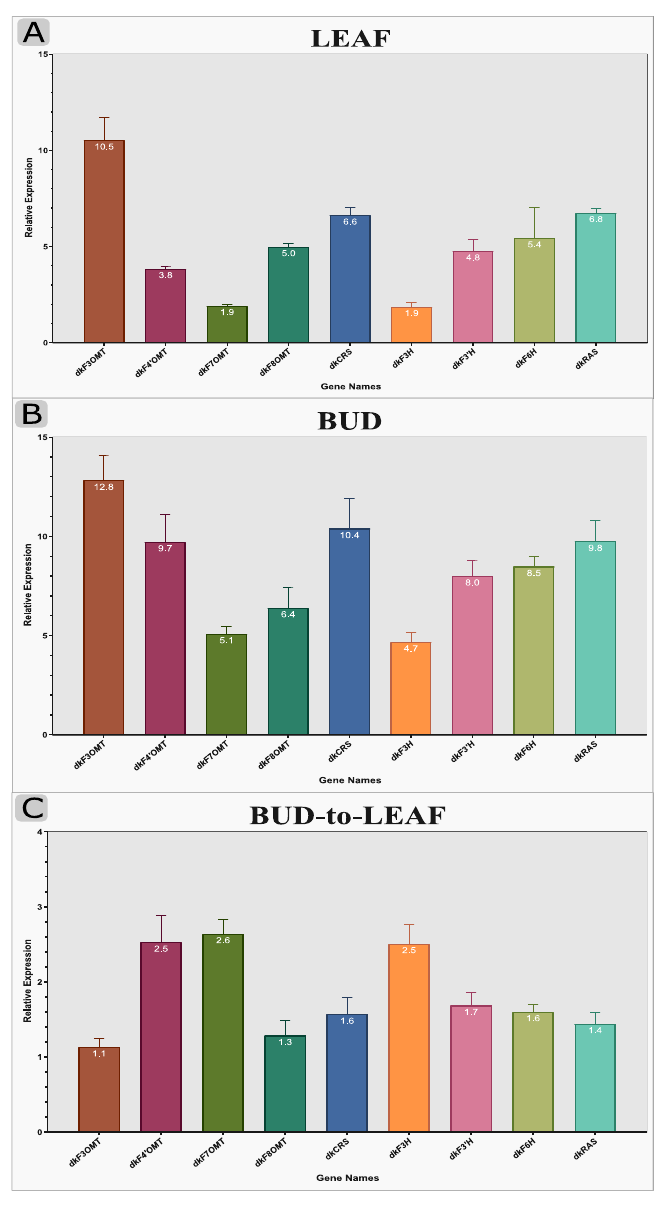
Figure 3. Expression pattern of selected genes from methoxylated flavones and rosmarinic acid biosynthetic pathway using qRT-PCR in D. kotschyi . Nine genes involved in methoxylated flavones and rosmarinic acid biosynthesis, namely; F3OMT, flavonoid 3-O-methyltransferases; F4 ʹ OMT, flavonoid 4 ʹ -O- methyltransferases; F6OMT, flavonoid 6-O-methyltransferases or CRS, cirsimaritin synthase; F7OMT, flavonoid 7-O-methyltransferases; F8OMT, flavonoid 8-O-methyltransferases; F3H, flavanone 3-hydroxylase; F3 ʹ H, flavonoid 3 ʹ -hydroxylase; F6H, flavonoid 6-hydroxylase; RAS, rosmarinic acid synthase, were selected for qRT- PCR analysis. The results represent the means ± standard error of experiments performed in